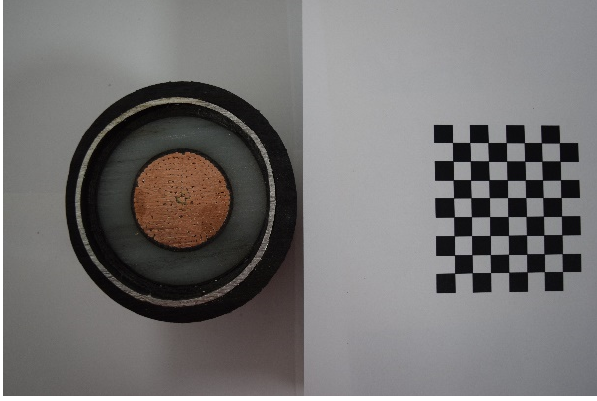
Figure 16 . Image of actual specimen cross-section. Figure 16. Image of actual specimen